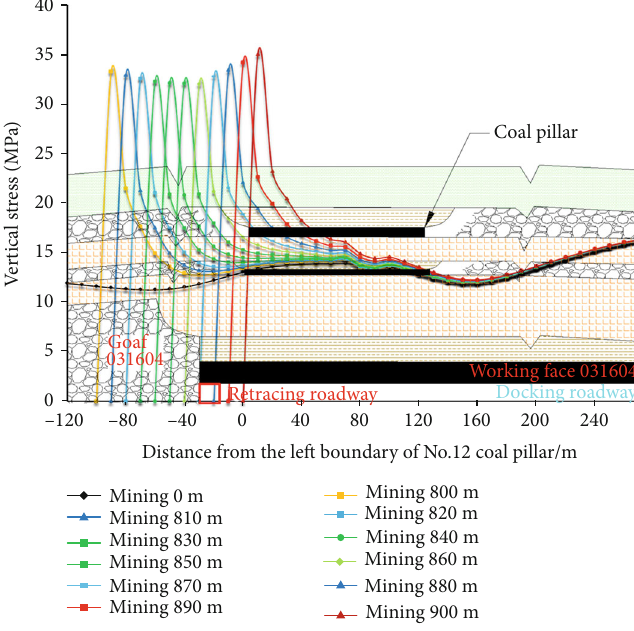
Figure 5: Distribution curve of vertical stress of surrounding rock mass in front of the working face under di ff erent mining